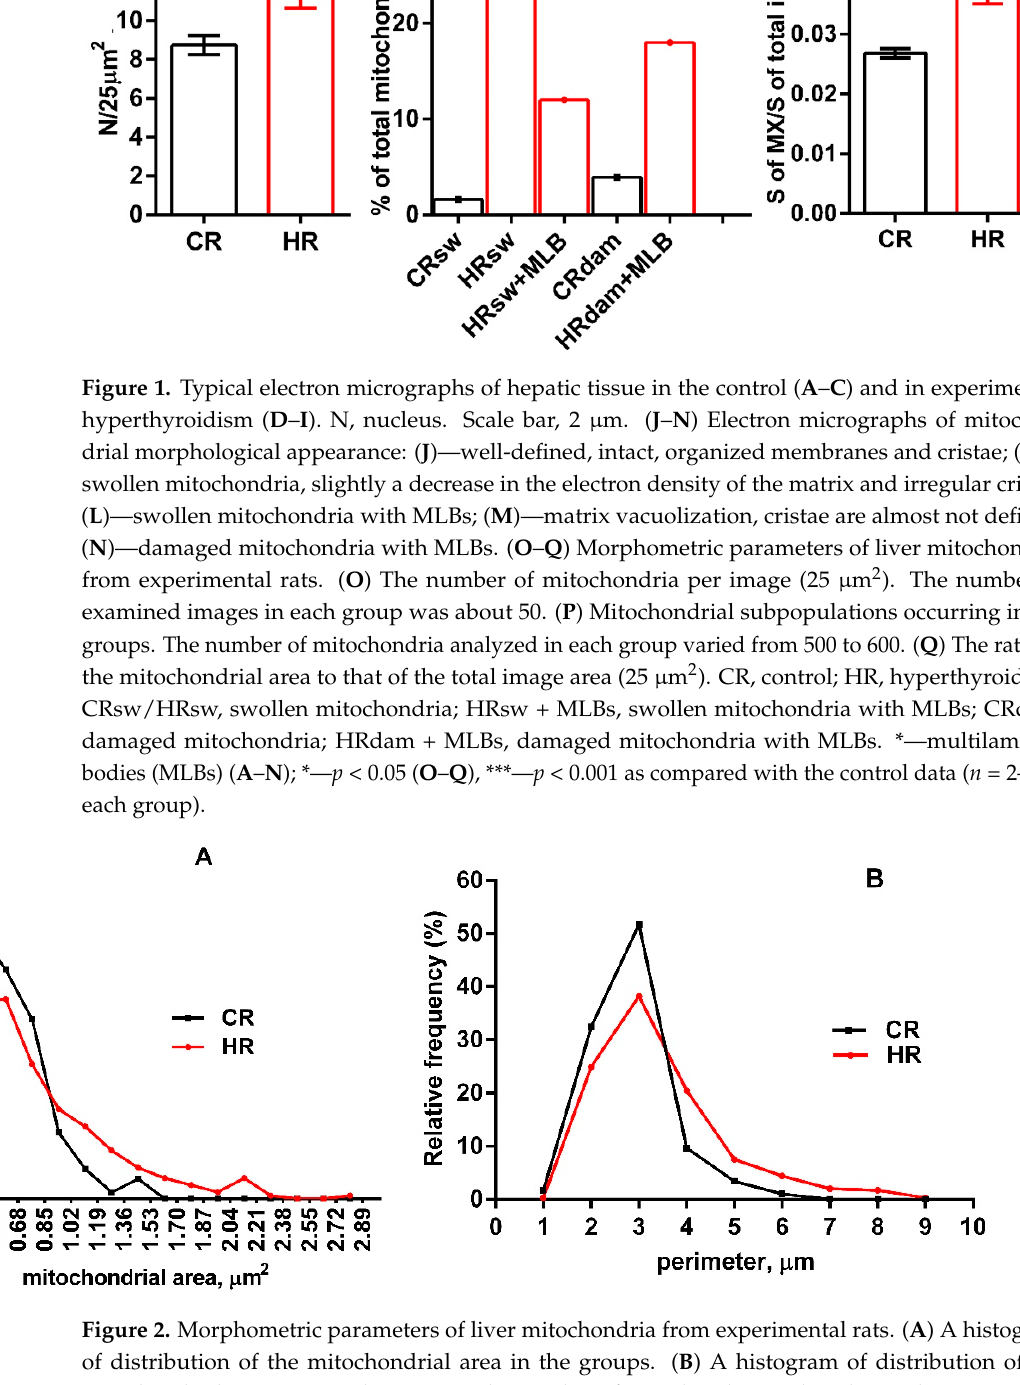
Figure 3. Relative mtDNA levels in the liver of animals. A real-time qPCR was carried out to deter- mine the mtDNA copy number, which is calculated as the ratio mtRNA to nuclear GADPH. CR- control, HR-hyperthyroidism. *— p < 0.05 compared with the control data ( n = 8). 2.4. Differences of Gene Expression in Liver Tissue of Control and Hyperthyroid Rats The observed decrease in the efficiency of ADP phosphorylation, as well as the oxi- dative stress in animals, could be associated with changes in biogenesis and mitochondrial dynamics occurring in the liver during the development of hyperthyroidism. To deter- mine the TH effects on these processes, we measured the expression of genes encoding proteins responsible for mitochondrial fusion (Mfn2 and Opa1) and fission (Drp1), mito- chondrial biogenesis (Ppargc1a) and mitophagy (PINK1 and Parkin). It turned out that HR had a three-fold increase in the expression level of Ppargc1a encoding the PGC-1 pro- tein, which mediates mitochondrial biogenesis (Figure 4). The levels of mRNA expression of the gene Mfn2 did not change; at the same time, the expression of two other genes (OPA1 and Drp1) involved in mitochondrial dynamics decreased in the HR liver by 1.7 and 1.4 times, respectively. Additionally, T 4 caused a significant decrease in Pink 1 and Parkin gene expression compared to CR (Figure 4).